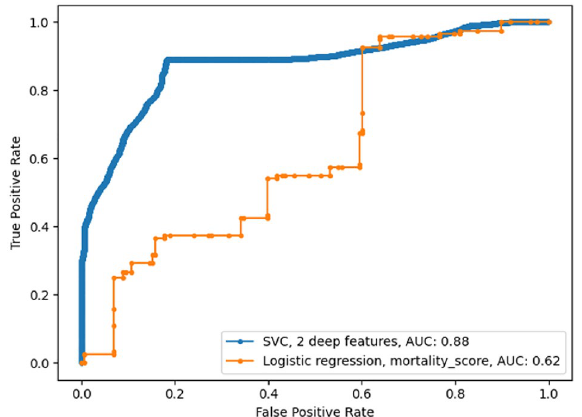
Figure 4. Cross-validated performances of the developed models. The best-performing classifier for the imaging features was a support vector classifier using 2 features with a linear kernel, achieving a 0.88 AUC. The mortality score model obtains a 0.62 AUC with a logistic regression model. There are 152 positive samples and 126 negative samples in the validation set.